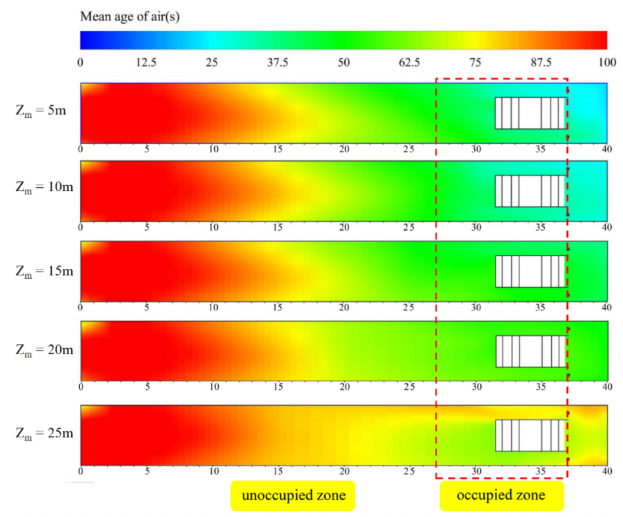
Figure 13. MAA distributions for different Z m